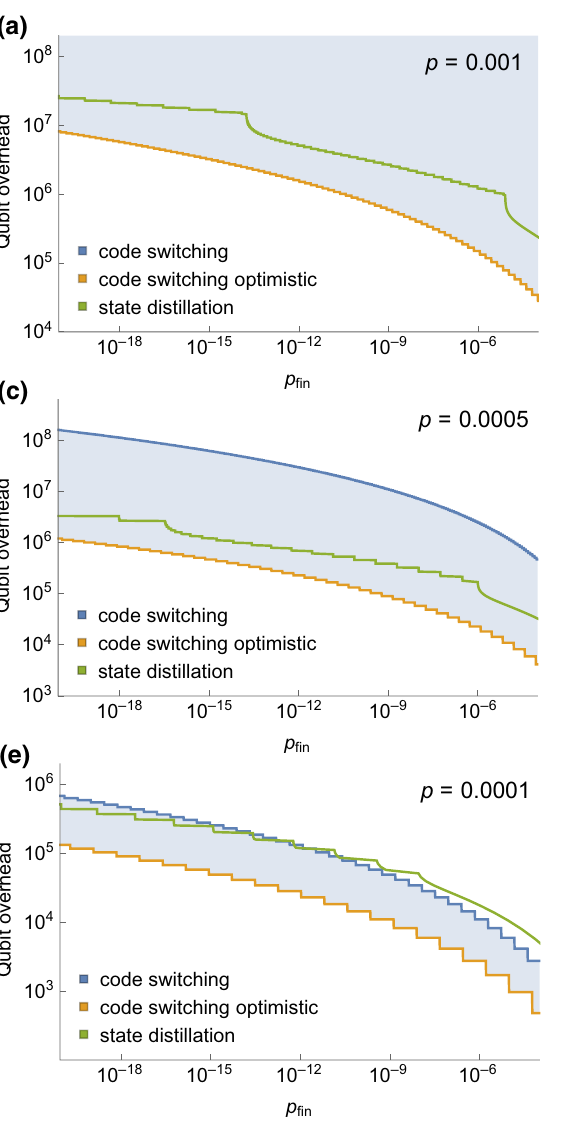
FIG. 2. Comparison of (a),(c),(e) the qubit and (b),(d),(f) space-time overhead as a function of the infidelity p fin of the output T state for state distillation and code switching. Possible future improvements of any steps of our code-switching protocol would be included within the shaded region. Note there is no code-switching curve for p = 0.001 without assuming optimistic improvements to the protocol as this is higher than the observed threshold for code